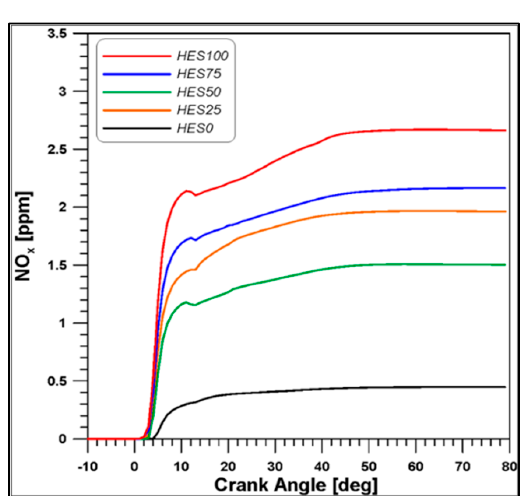
Figure 29. NO x emissions.